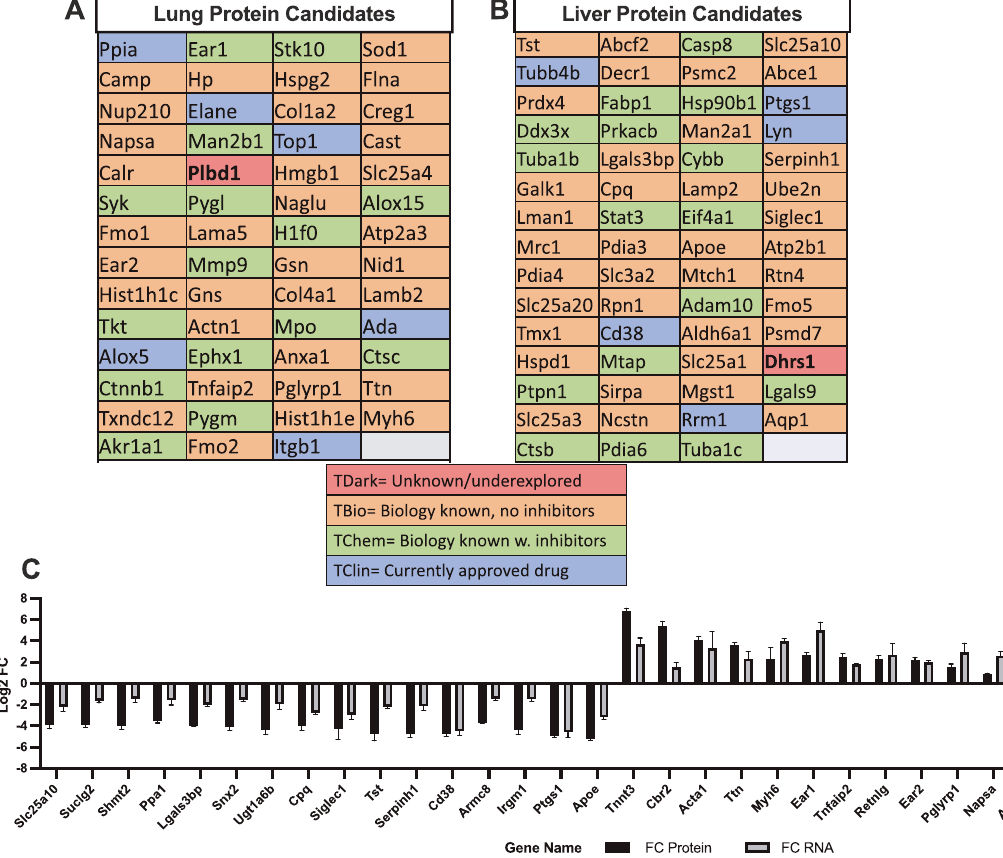
Fig. 3 Potentially druggable protein targets from LM and LuM CD11b + cells with correlating transcriptomic data. The drug – gene interaction database (DGIdb) and PHAROs drug – target development data mining platforms highlight possible targets for future validation experiments and translational studies based on current protein knowledge ( A and B ). Positive correlating proteomic and transcriptomic data ( C ) show possible targets for future MDSC modulating strategies for LuM- or LM-speci fi c MDSCs. Data shown n = 4 per tissue type mean + / −